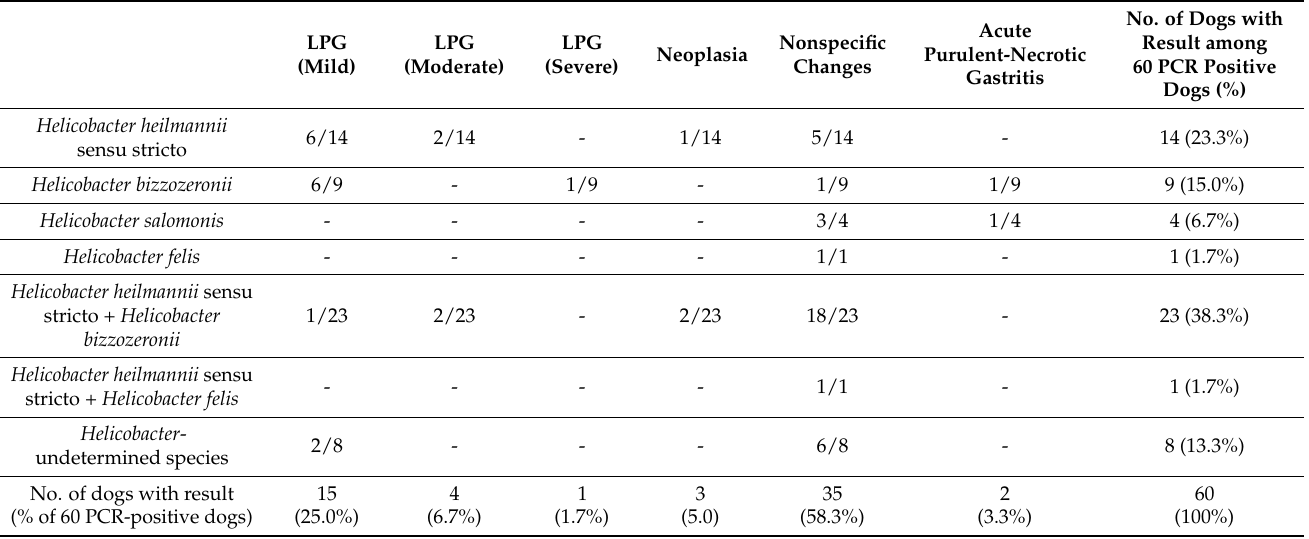
Table 5. Histopathologic findings in 60 dogs infected with different Helicobacter species (detected by PCR).